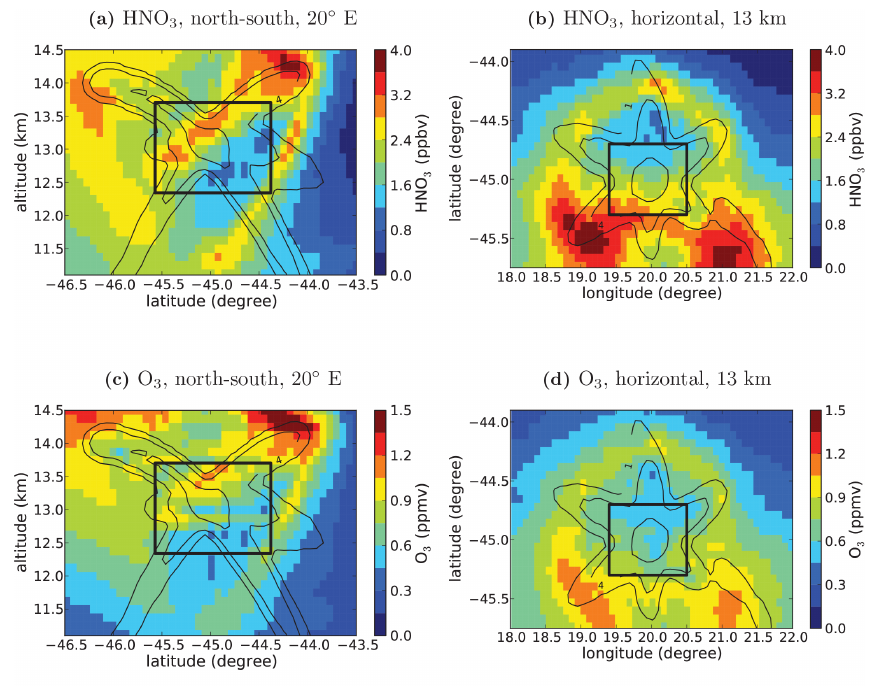
Figure 18. Retrieved HNO 3 and O 3 mixing ratios at 20 ◦ E (left) and 13km altitude (right) for 13:30–14:30UTC, 13 September 2012. For details see caption of Fig. 17.